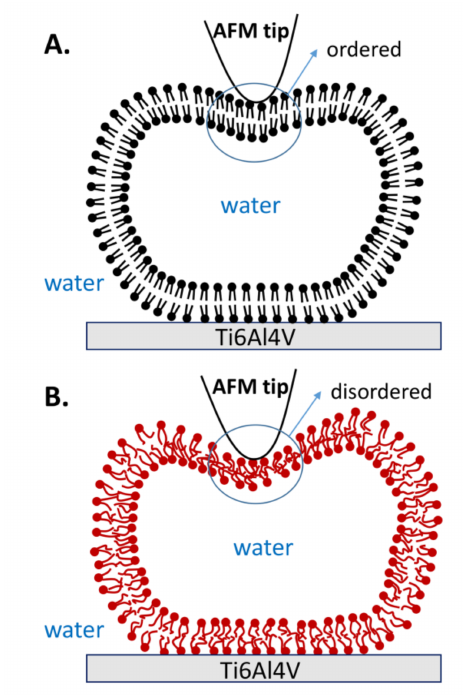
Figure 9. Schematic illustrations of vesicle deformation by AFM tip when lipid molecules are in ( A ) the gel phase and ( B ) the liquid phase.